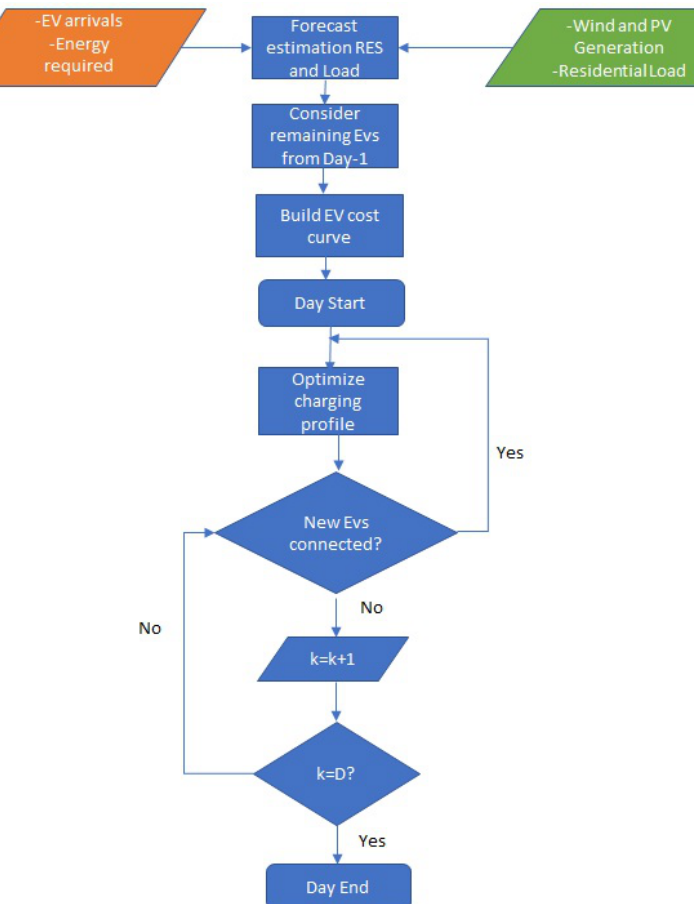
Figure 2. Flowchart of the optimal EV charging for each interval in a